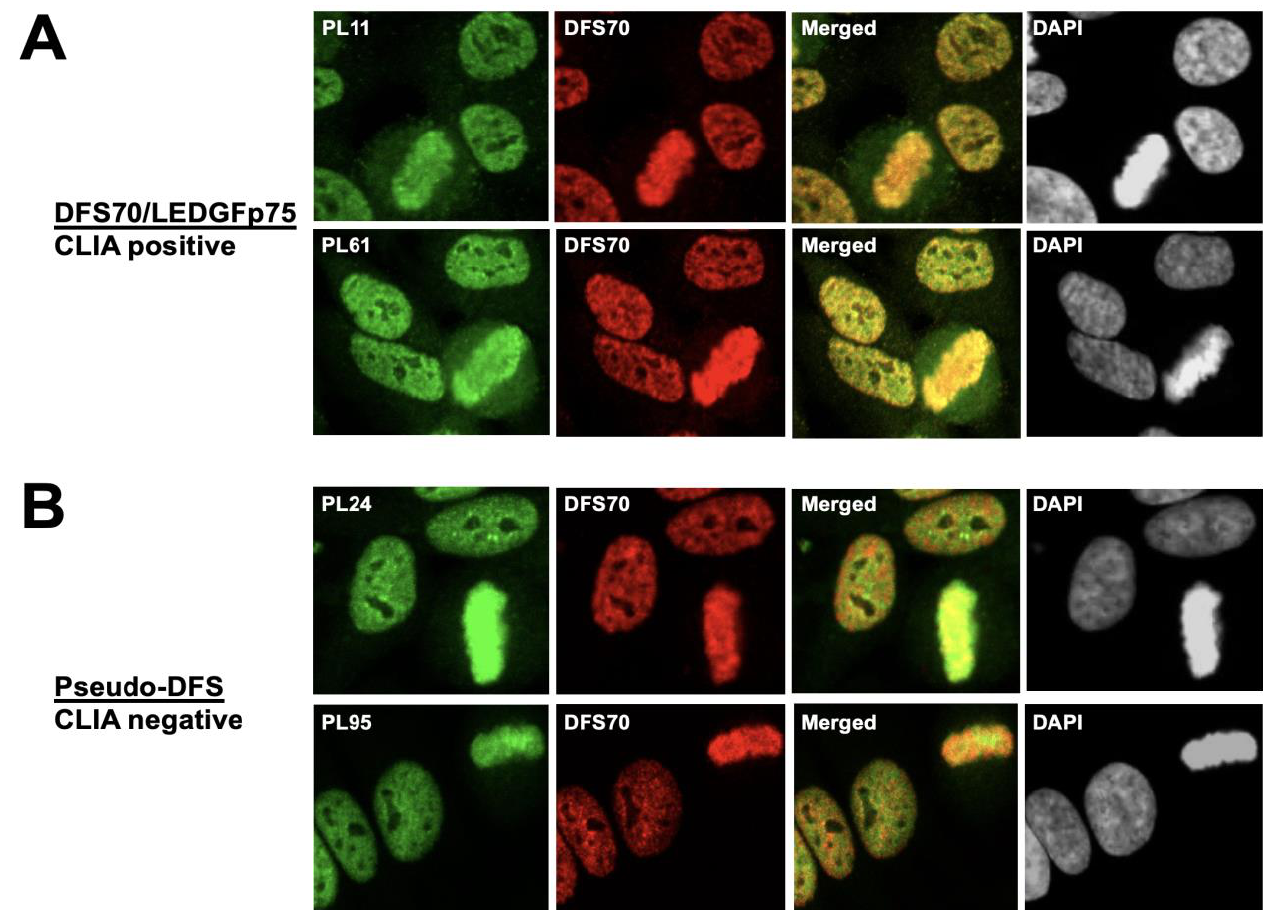
Figure 3. Co-localization of IFA patterns of monospecific CLIA anti-DFS70-positive and CLIA anti- DFS70-negative human antibodies with the DFS pattern produced by anti-DFS70/LEDGFp75 rabbit antibodies. ( A ) CLIA anti-DFS70-positive sera PL11 and PL61 (green) producing the classical DFS IFA pattern were co-incubated with a rabbit antibody to DFS70/LEDGFp75 (red) in the standard HEp-2 test. Extensive co-localization between the DFS70/LEDGFp75 proteins recognized by the human autoantibodies and the rabbit antibody can be observed, as evidenced by the yellow/orange fluorescence in the merged images. ( B ) Monospecific CLIA anti-DFS70-negative sera PL24 and PL95 (green) were co-incubated with a rabbit antibody to DFS70/LEDGFp75 (red). While areas of co-localization between the human pseudo-DFS antibodies and the rabbit anti-DFS70/LEDGFp75 antibody can be detected (yellow/orange fluorescence), this co-localization is not as extensive as that obtained with CLIA anti-DFS70-positive sera (shown in panel A) given the increased separation of red and green fluorescence in the merged images. Images were obtained by confocal microscopy. Chromatin staining with DAPI is presented in black and white for better visualization.